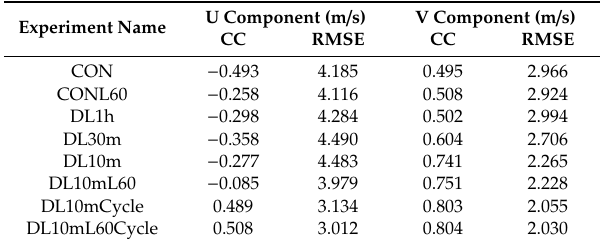
Figure 7. Time series of 10 m ( a ) U and ( b ) V components observed by the AWOS station and their model equivalents from eight experiments. The shaded areas indicate the maximum and minimum observations in 10 min. Table 3. RMSEs and CCs of observed 10 m U and V components and their model equivalents from eight experiments.